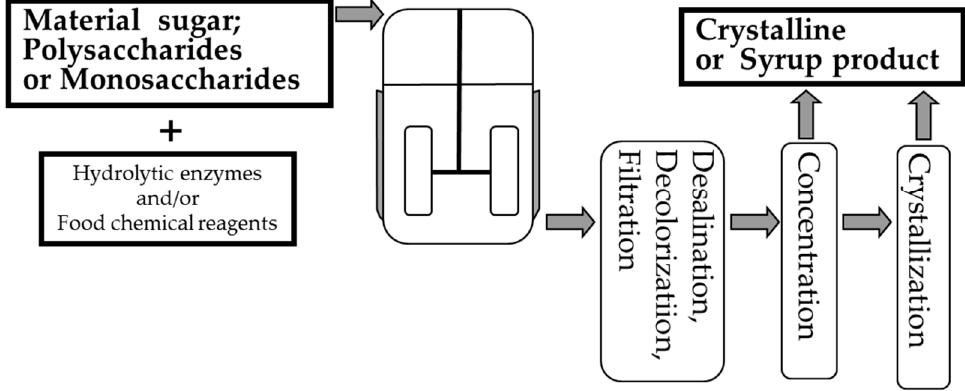
Figure 3. Schematic diagram of hexose production using hydrolytic enzymes or food chemical reagents.